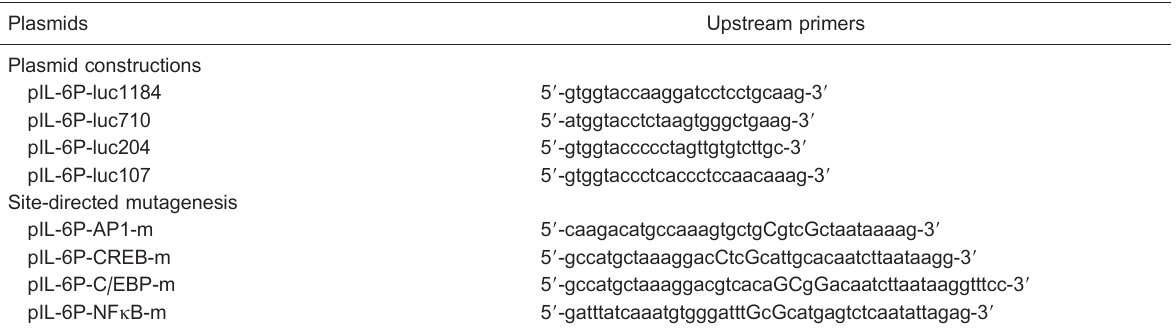
Table 1. Sequences of upstream primers used in the plasmid constructions and site-directed mutagenesis. Plasmids Upstream